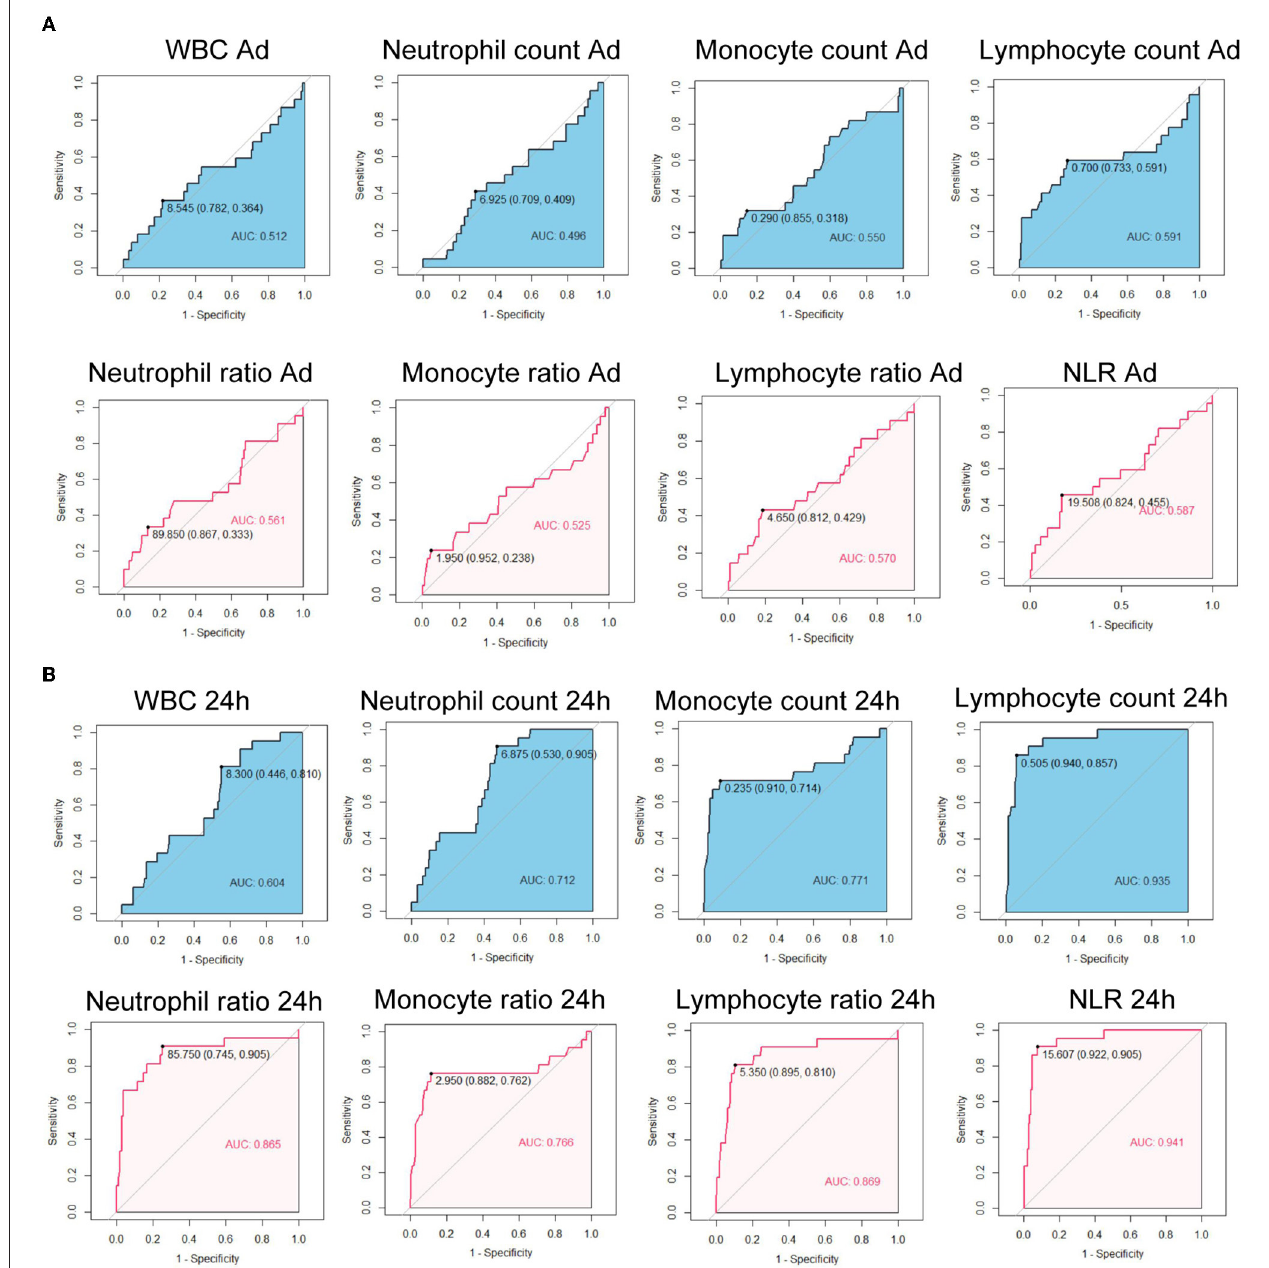
FIGURE 1 | Receiver operating characteristic curves of immune cell counts and ratios at admission (A) and at 24h after admission (B) for 90-day fatality in patients with exertional heatstroke (EHS). WBC, white blood cell; NLR, neutrophil to lymphocyte ratio; AUC, area under